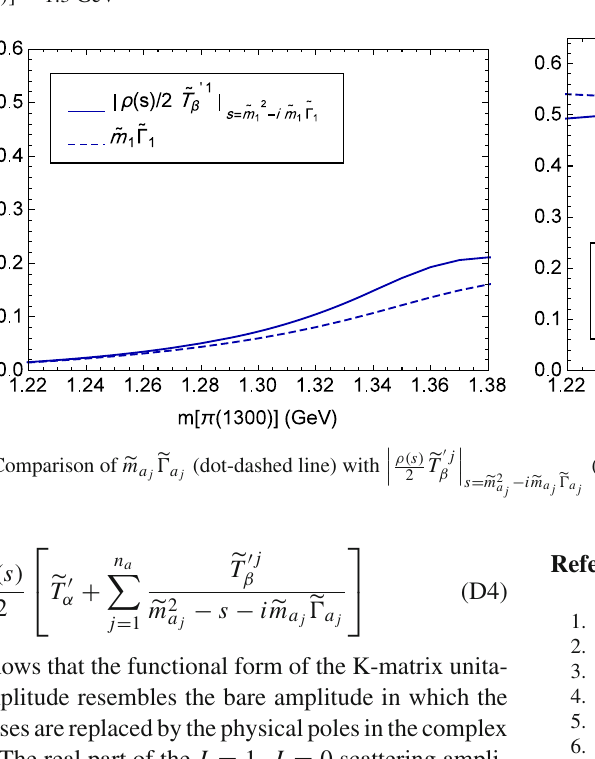
Fig. 20 Close agreement of the K-matrix unitarized I = 1, J = 0, πη scattering amplitude with the expansion (D4) for A 3 / A 1 = 30 and m [ π( 1300 ) ] = 1 . 3 GeV